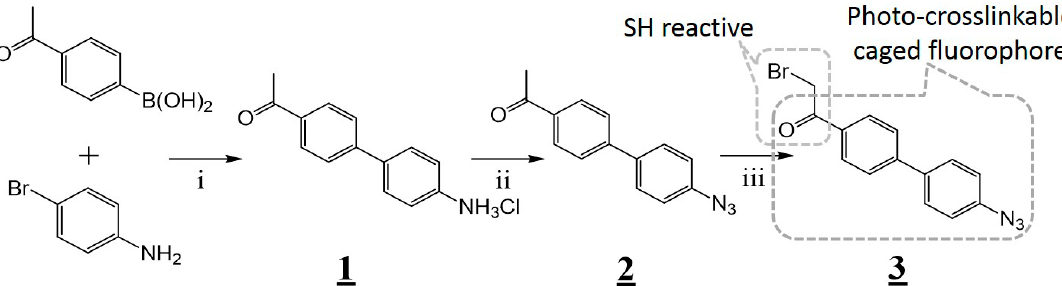
Figure 2. Overall scheme for the synthesis of the cysteine-reactive small photo-crosslinker 3 . Reagents